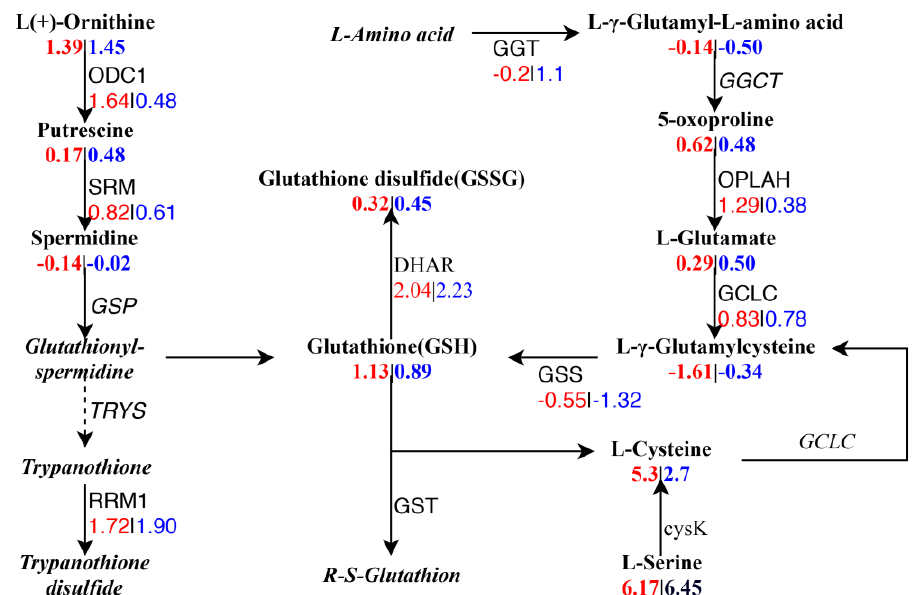
Figure 9. Network of the glutathione metabolism pathway. The location of the node is metabolites and the substances on the line are genes. Metabolites and genes in italics were not detected. Some of them that were una ff ected by HS have been omitted from this graph. The red numbers represent the | log2fold change | of genes or metabolites for control and HS in 17CL30, while the blue number represents the | log2fold change | of genes or metabolites for control and HS in 05S180.